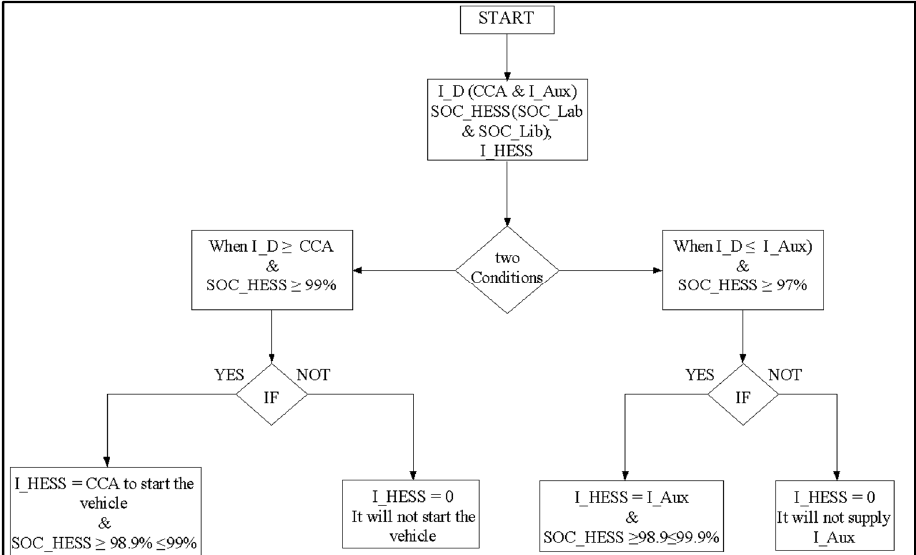
Figure 4. Flow chart of the proposed BMS in HESS during discharging mode.